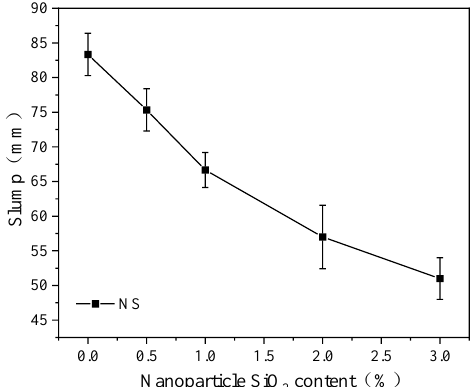
Figure 2. Slump of concrete with nano-SiO 2 .